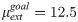
Finding shortcut and adaptive planning.(a, b) Turning up the noise level in the external input (indicated below each column) may be a way to prevent the detection of a shortest path. Other parameters as indicated in the caption of Fig 3. (c) Adaptive planning for a moving goal. A goal at initial goal position (17,7) is moved along the red line after planning time is over and the agent heads from the start towards this goal position. The goal moves one step at each readout cycle. The moving target can reliably be traced (blue line). The planning time is 1 s and the readout time is 250 ms. μextgoal=12.5, μ
ext = 12.